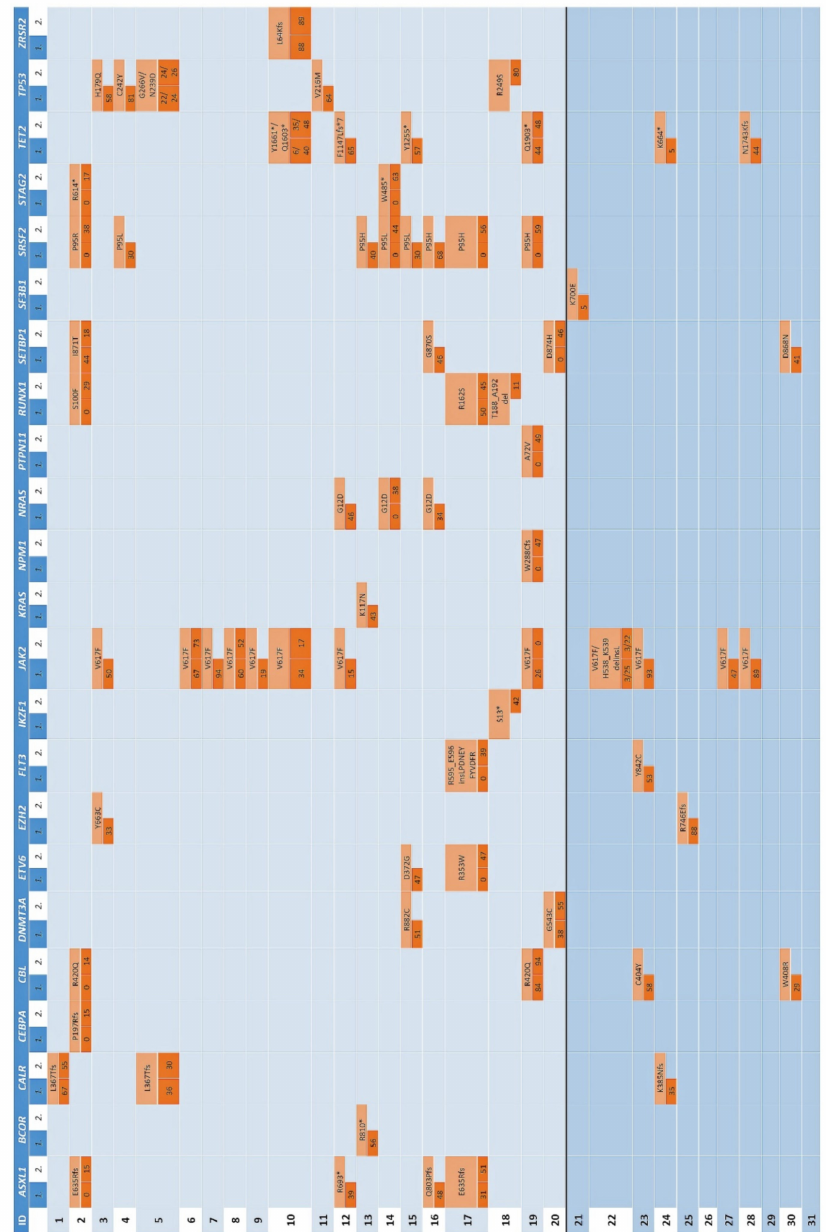
Figure 2. Results of the targeted mutation analysis performed either by an AmpliSeq Custom Panel, the commercially available Oncomine™ Myeloid Research Assay (Thermo Fisher Scientific), or by both. Only mutations rated as “pathogenic” or “likely pathogenic” by VarSome were considered. Each patient is represented by one line with an individual ID. Each column represents one gene that was mutated in at least one sample. If mutated, the box is highlighted in orange and the according human genome variant society-nomenclature on protein level is given in the upper part of the box. In the lower part, the respective allelic frequency of the first available biopsy is given on the left side (subcolumn “ 1. ”), and the allelic frequency of the follow-up sample is shown on the right side (subcolumn “ 2. ”). If a mutation was detected with both panels, the mean of the indicated allelic frequencies is reported. Boxes highlighted with orange and an allelic frequency of “0” represent cases without detectable mutation in the respective sample. If allelic frequency of a mutated gene is not given, molecular work-up on the respective sample was not possible (blue